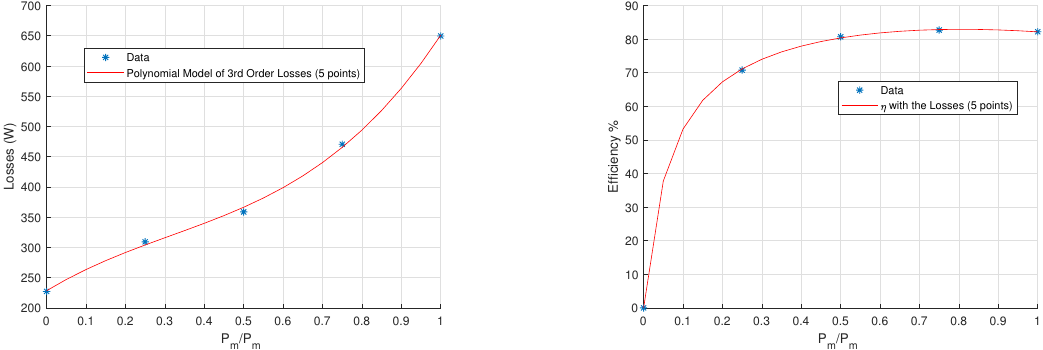
Figure 5. Loss and Efficiency Curves of the Motor Based on the Polynomial Model of 3rd Order Losses.